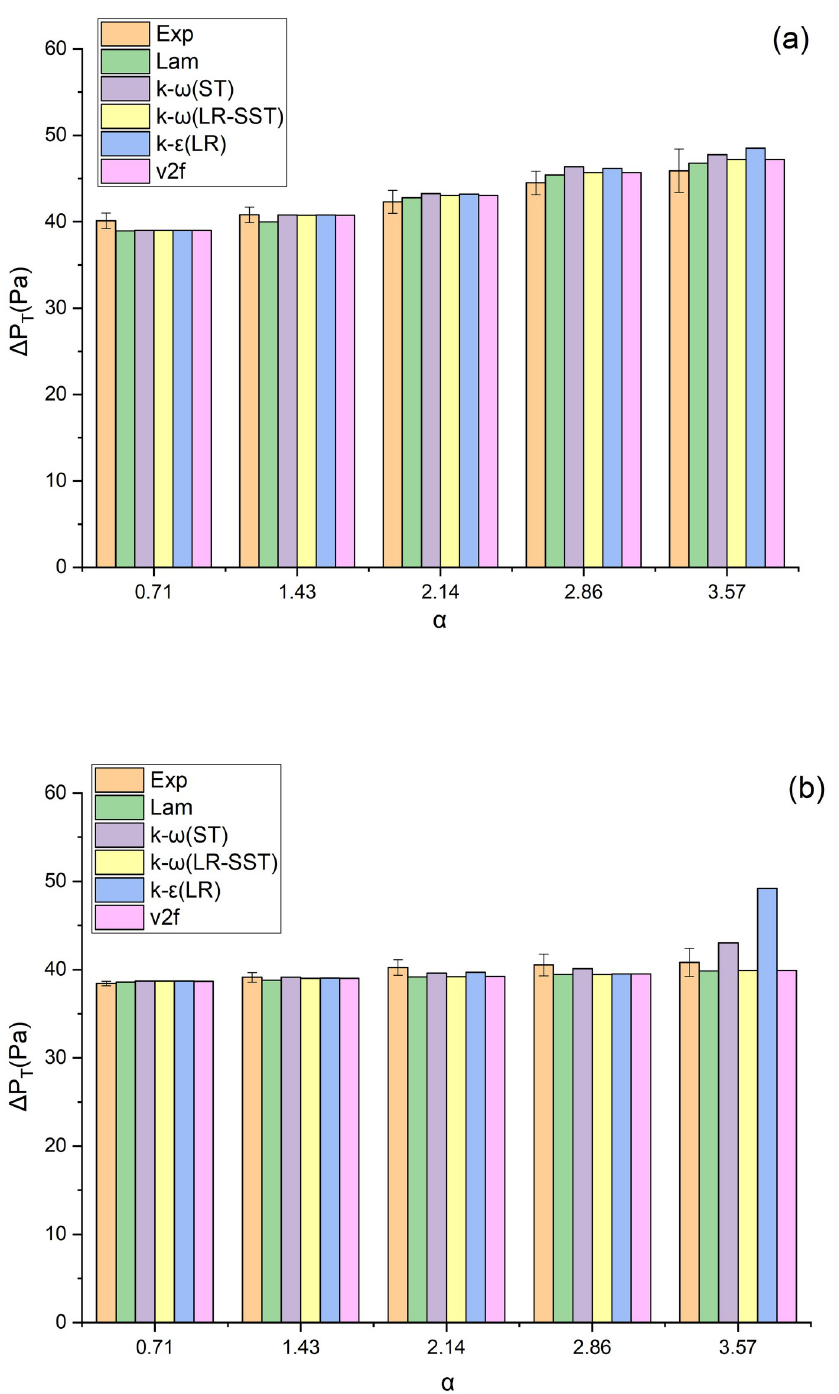
Fig 8. Pressure drops of the filter under different CFD models (a) V-shaped, (b) U-shaped.